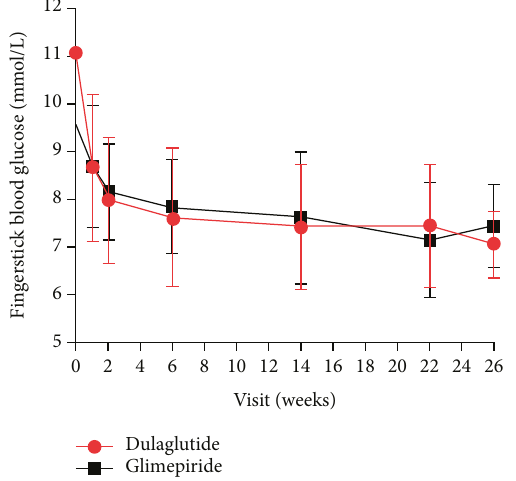
Figure 2: Fingerstick BG of two groups from 0 week to 26